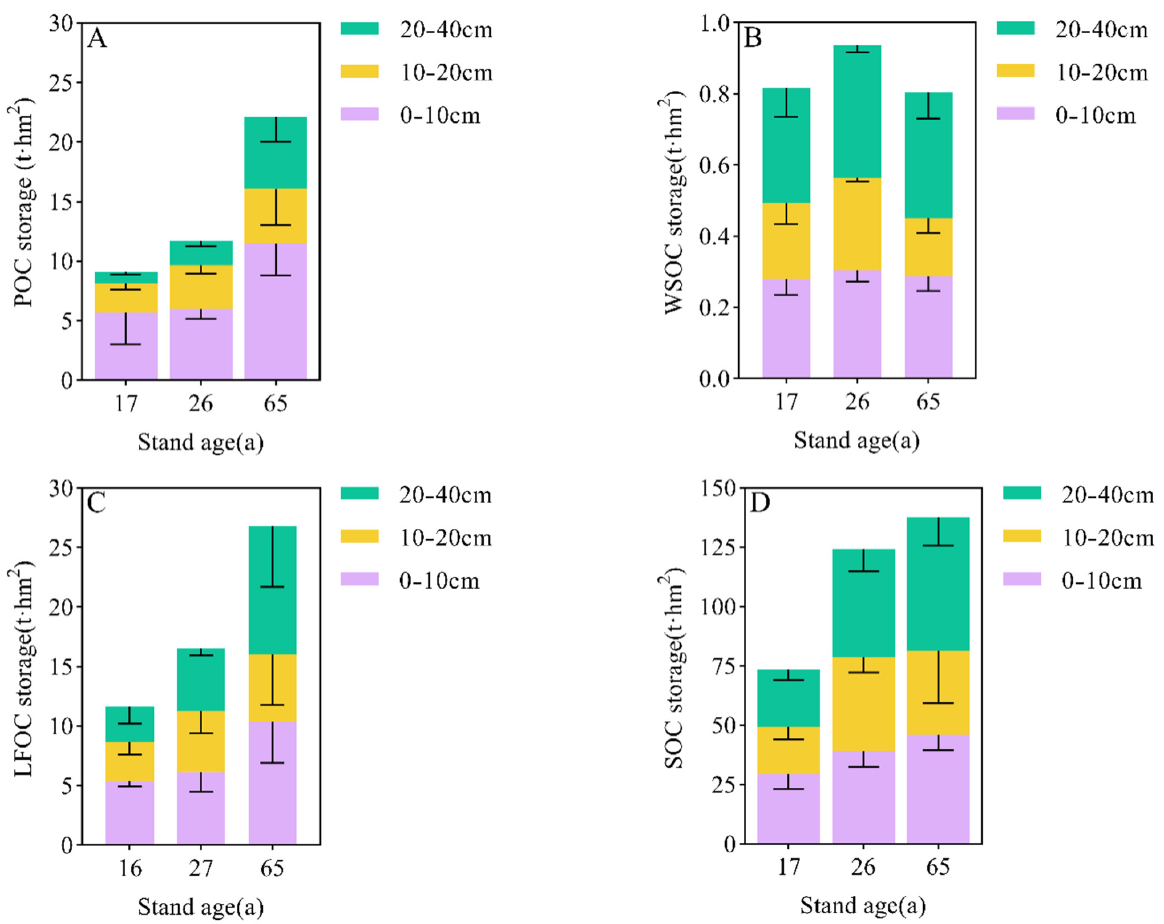
Figure 6. Soil carbon storage of three age groups. particulate organic fraction (POC, A);soil water- soluble organic carbon (WSOC, B); light fraction organic carbon (LFOC, C); soil organic carbon (SOC, D) (mean ± SD, n = 3).